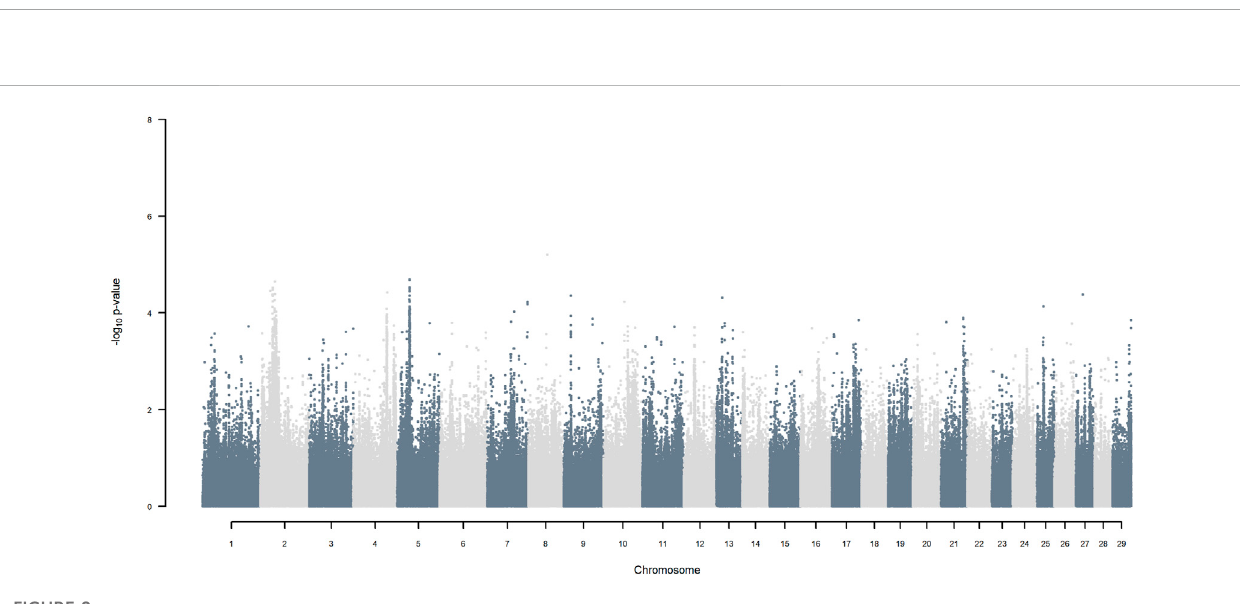
FIGURE 8 Manhattan plot of GWAS (Models 3 & 4) for HF versus Jersey origin using SNP alleles of all origins that had a MAF >